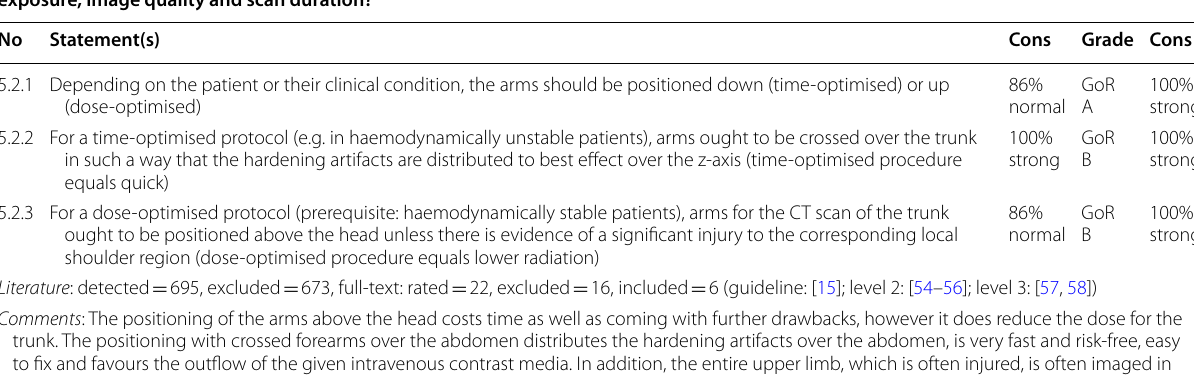
Table 9 Section 5: Whole Body CT – Positioning, key issue 2: Arm position